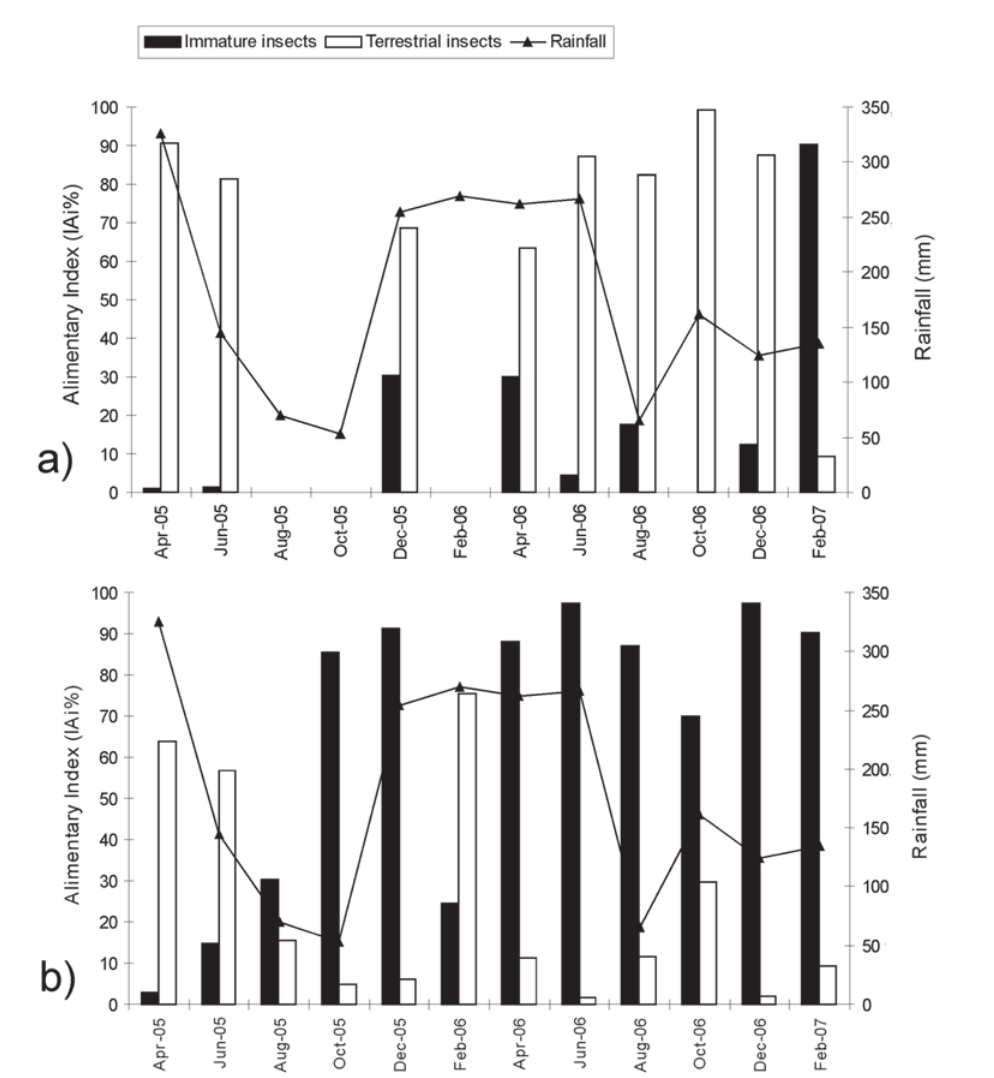
Fig. 2. Seasonal variation in role of terrestrial and immature insects in diet of B. caudomaculatus (a) and B. alburnoides (b) in the region affected by the Balbina Reservoir, Uatumã River,